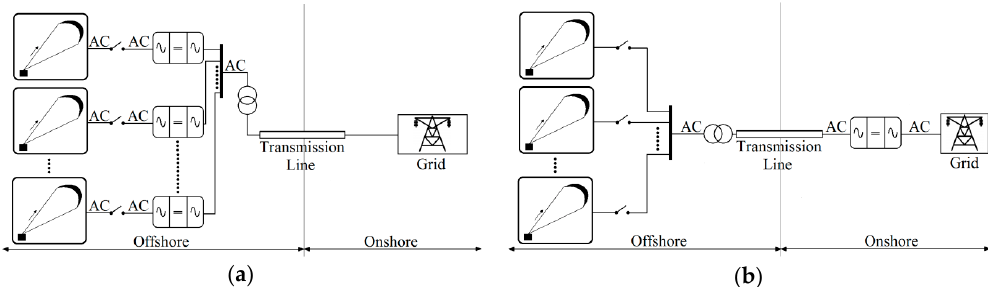
Figure 2. Conventional approach and direct interconnection technique for an off-shore AWE farm: ( a ) conventional interconnection method; and ( b ) direct interconnection technique.